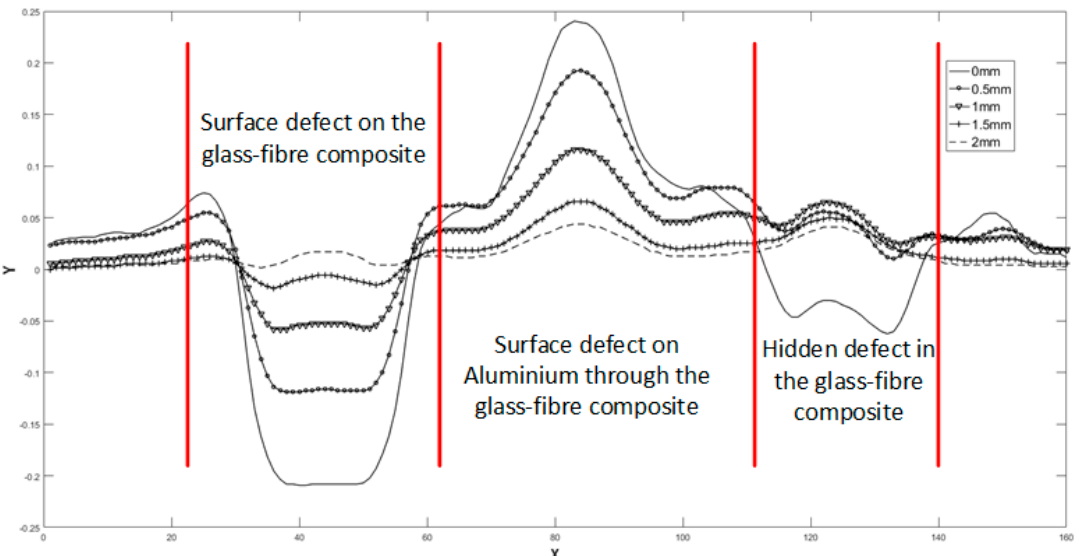
Figure 24. Extracted lines from the capacitive images taken at various lift-offs.